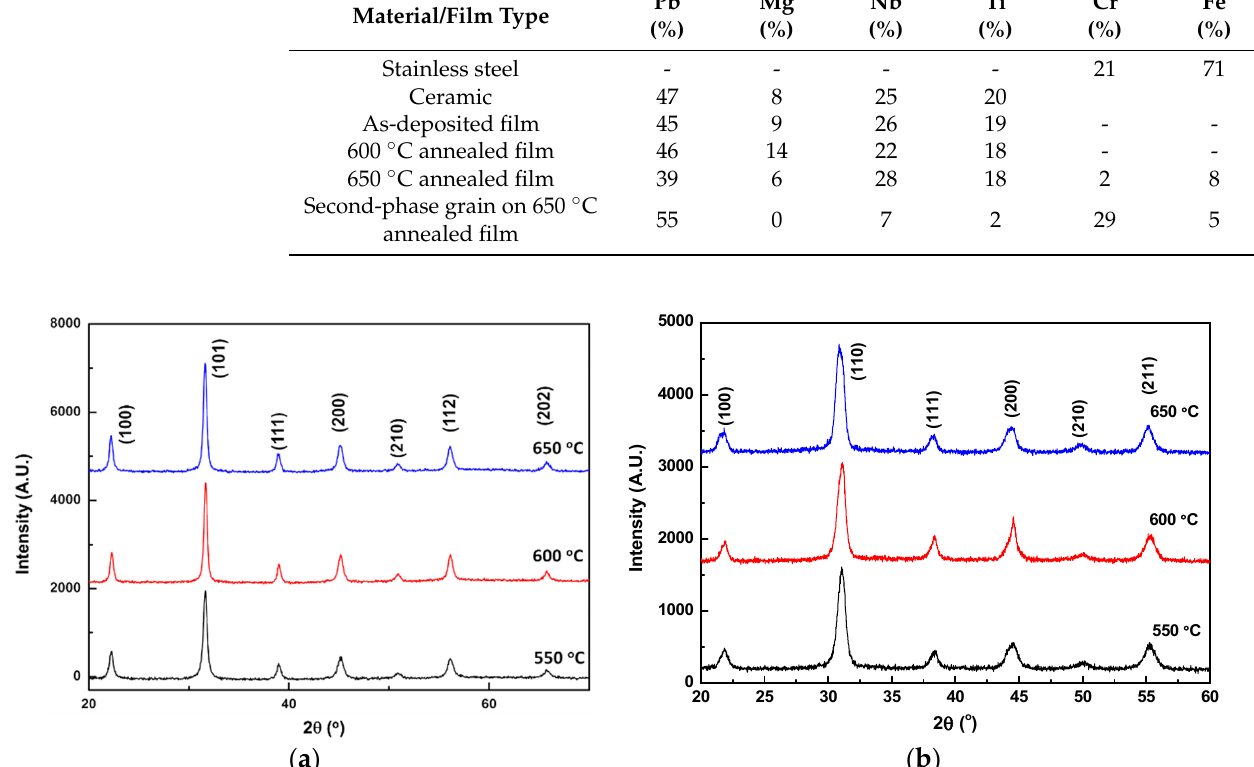
Figure 7. XRD patterns of the ( a ) PMN–PT and ( b ) PZT films annealed under 550, 600, and 650 °C.